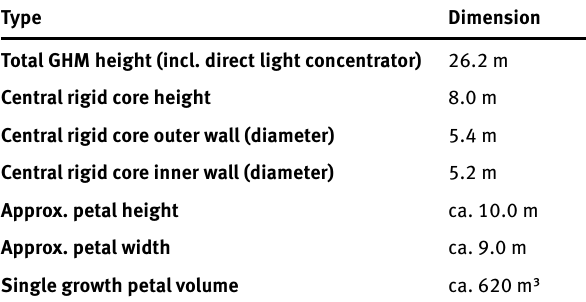
Table 1: Overview of main dimensions of the GHM system.